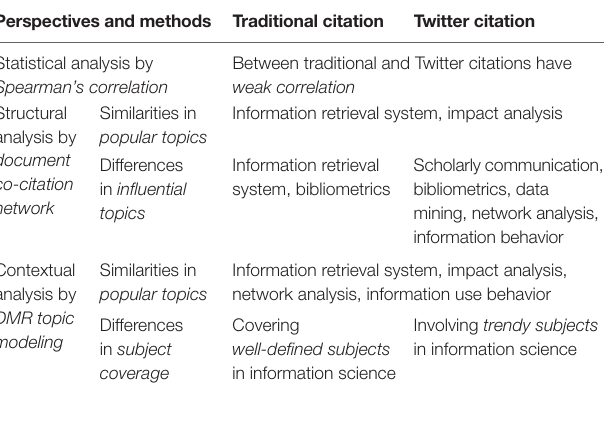
TaBle 4 | summary of the similarities and the differences between two different citation behaviors. Perspectives and methods Traditional